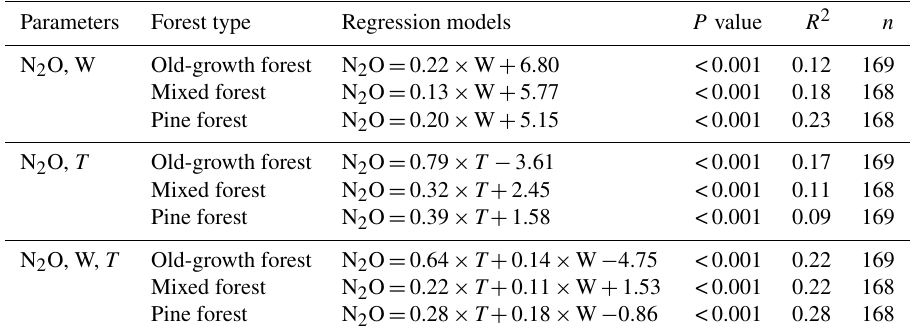
Figure 3. Seasonal variation of N 2 O fluxes in the three study forests during the sampling periods. Each error bar represents standard error of mean N 2 O fluxes from five plots ( n = 5), and the data of N 2 O fluxes in each plot have been averaged by season (3 months). Differ- ent lowercase letters within each season represent significant differences among treatments, as determined by repeated-measures ANOVA ( P <0.05). Table 4. Models for the relationships between N 2 O fluxes (N 2 O), soil WFPS (W), and temperature ( T ) in the control plots of the study